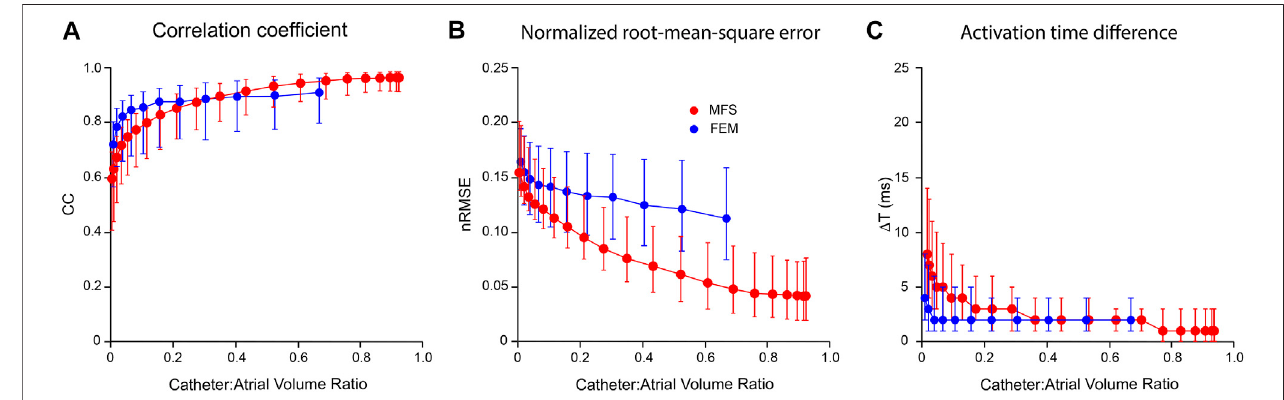
FIGURE 6 | Comparison of inverse potential maps reconstructed during macro-reentry using FEM and meshless methods that employ the MFS. LA surface potentials throughout 3 activation cycles in simulated atrial fl utter reconstructed from electrograms sampled inside LA cavity with 130-electrode basket catheters and compared with ground-truth data. (A) Correlation coef fi cient (CC) (B) normalized root-mean-squared error (nRMSE), and (C) activation time difference ( Δ T) are presented as functions of catheter-atrial volume ratio for FEM (blue) and meshless/MFS (red). Median values and interquartile range are given. Abbreviations: FEM, fi nite element method; MFS method of fundamental